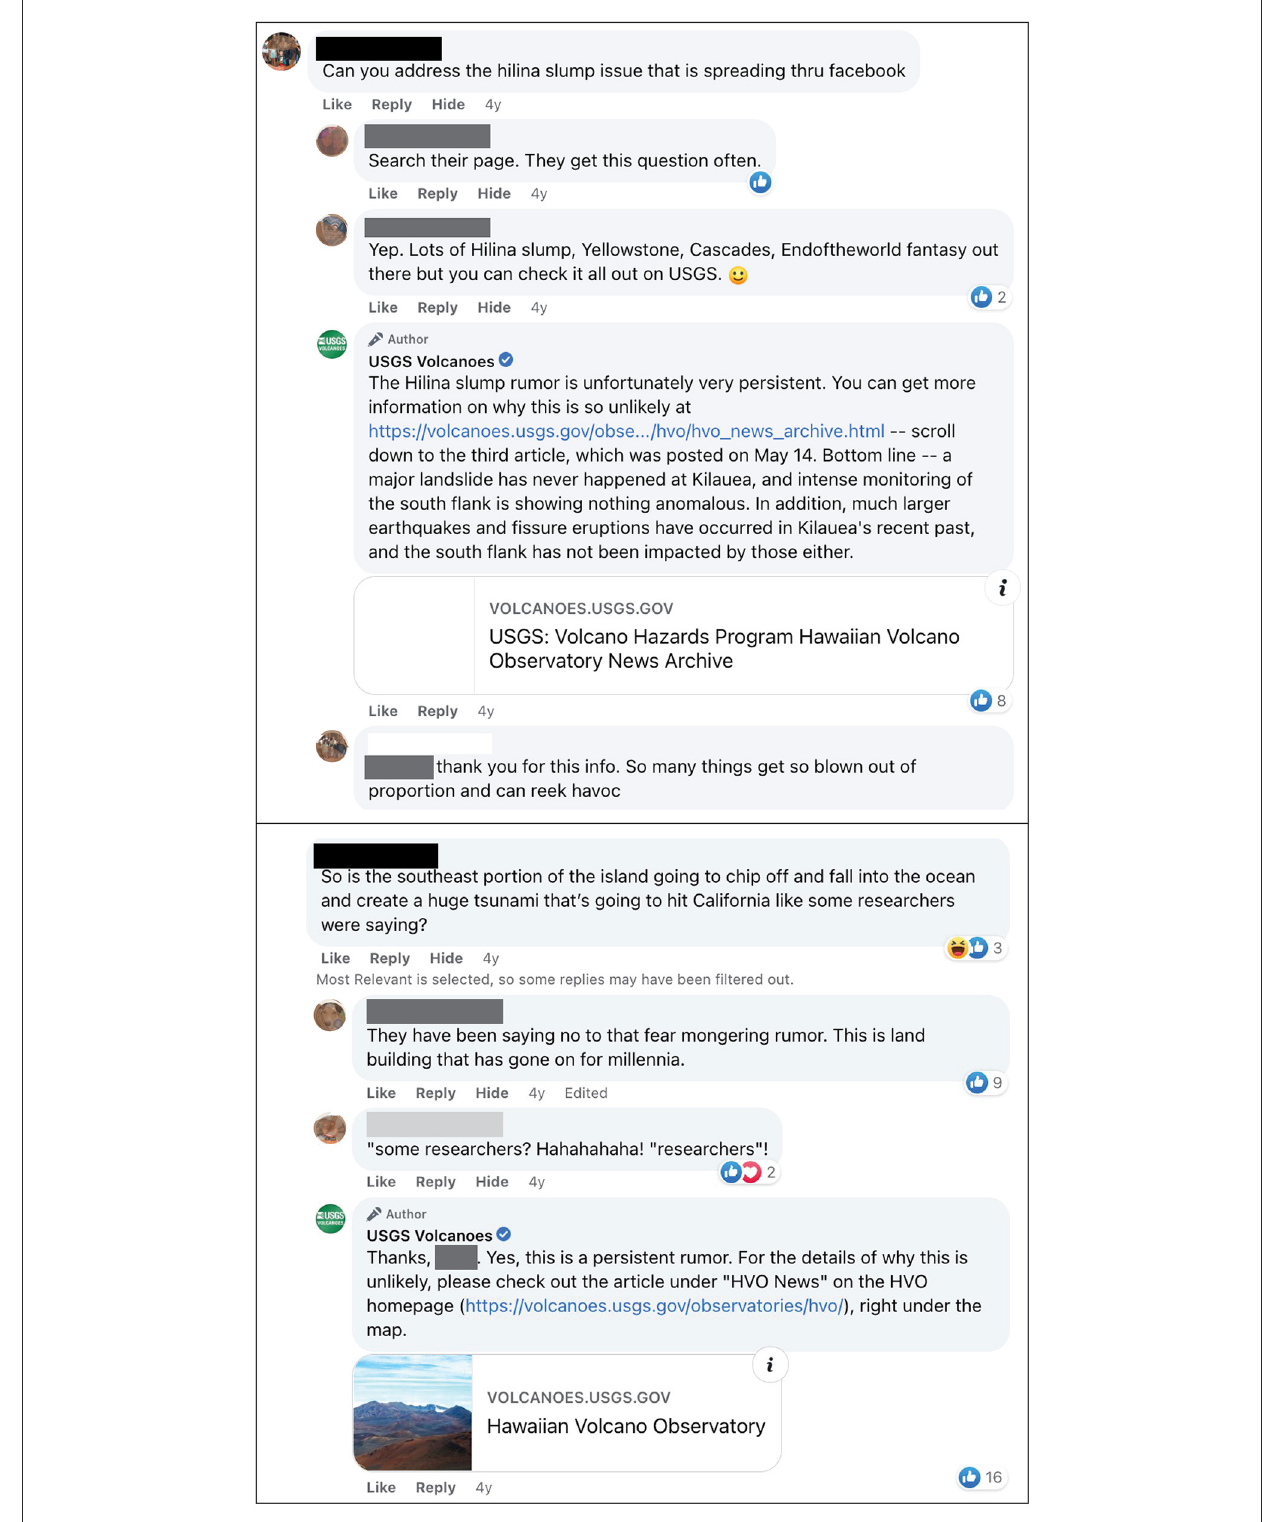
FIGURE8 Two comment strings related to a common concern that the southern portion of the Island of Hawaii was going to slide off into the ocean in a catastrophic fashion. Followers addressed questions to USGS Volcanoes, and often the community answered with recommendations of where to find additional